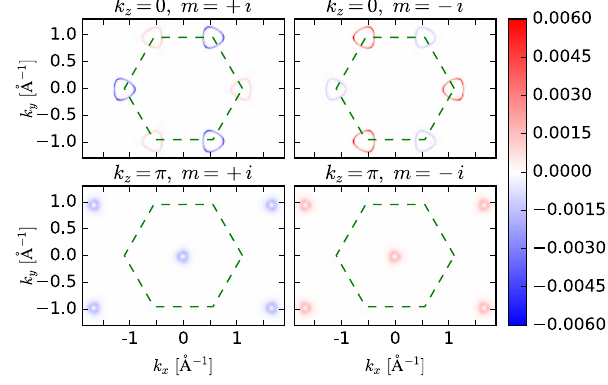
FIG. 12. The Berry curvature for specific mirror eigenvalues on σ -mirror invariant planes in ZrTe. h